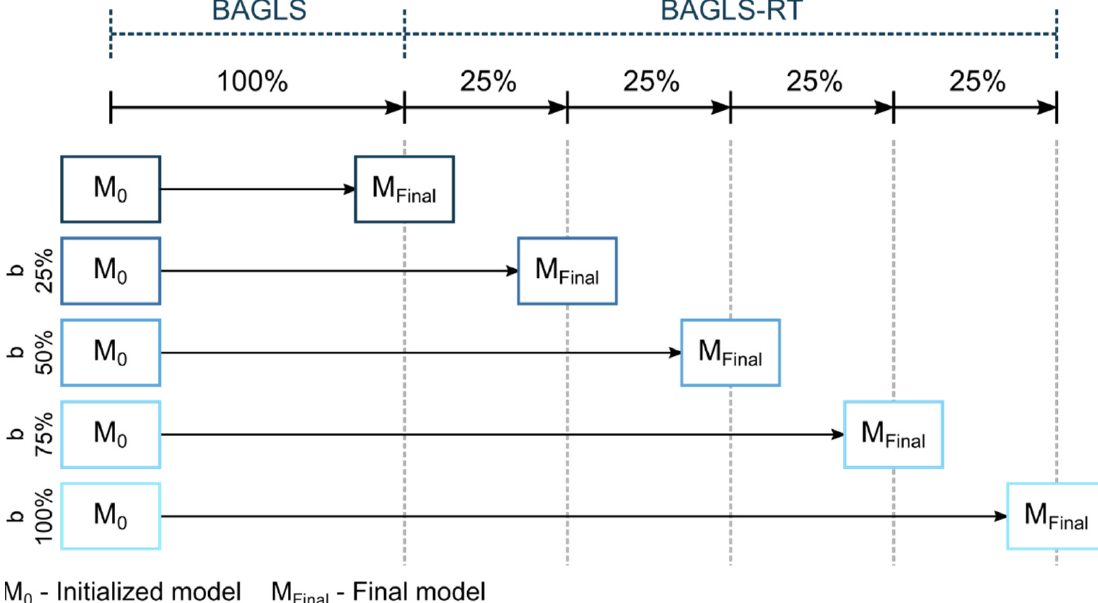
Figure 7. Illustration of re-training from scratch for the different batch sizes.